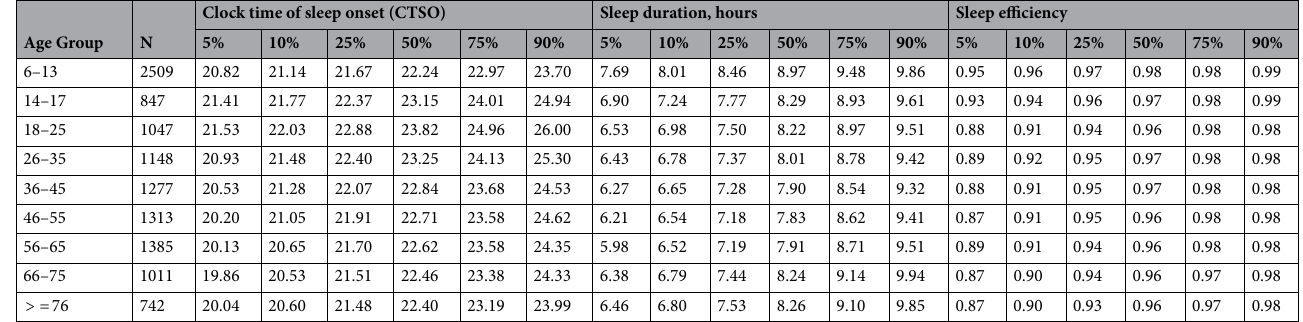
Table 2. Distribution of clock time of sleep onset, sleep duration and sleep efficiency by age groups.